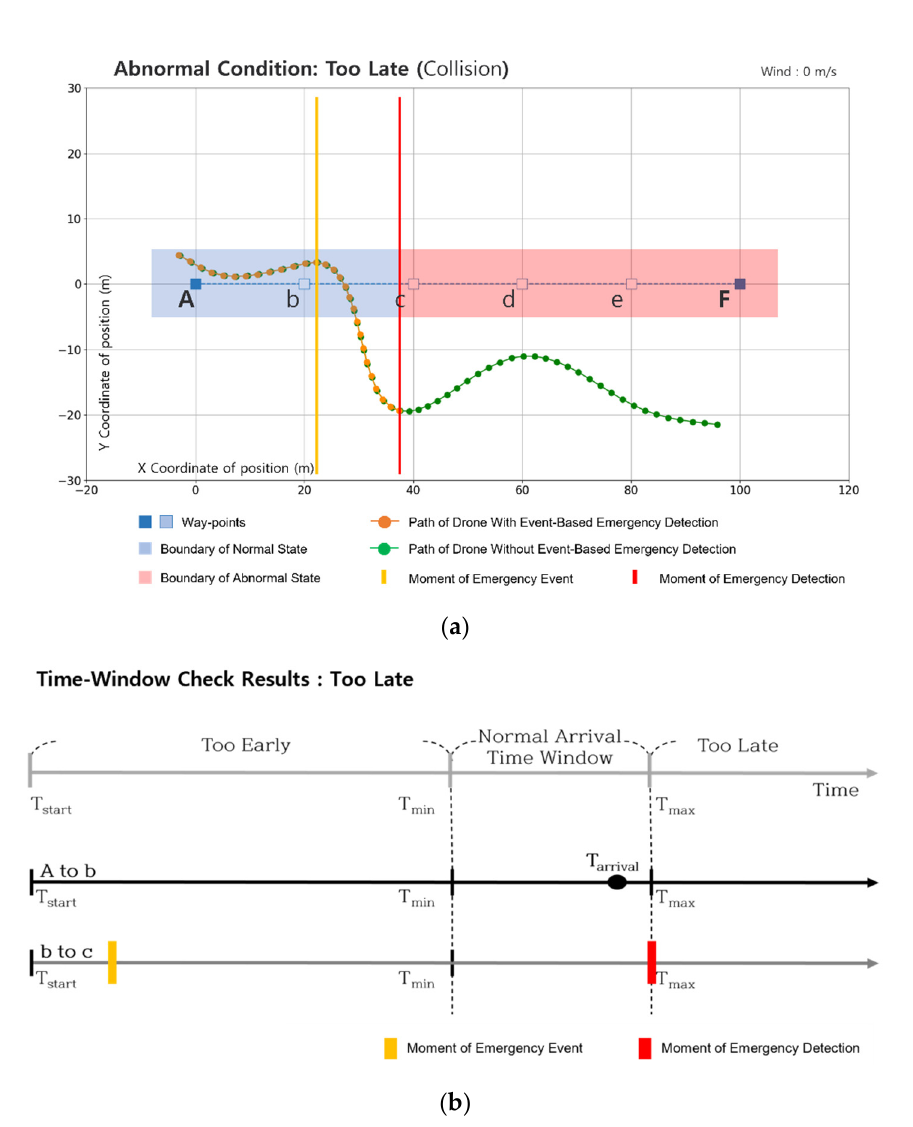
Table 3, the actual numerical time data including T start , T min , T max , and the actual arrival time T arrival is displayed.